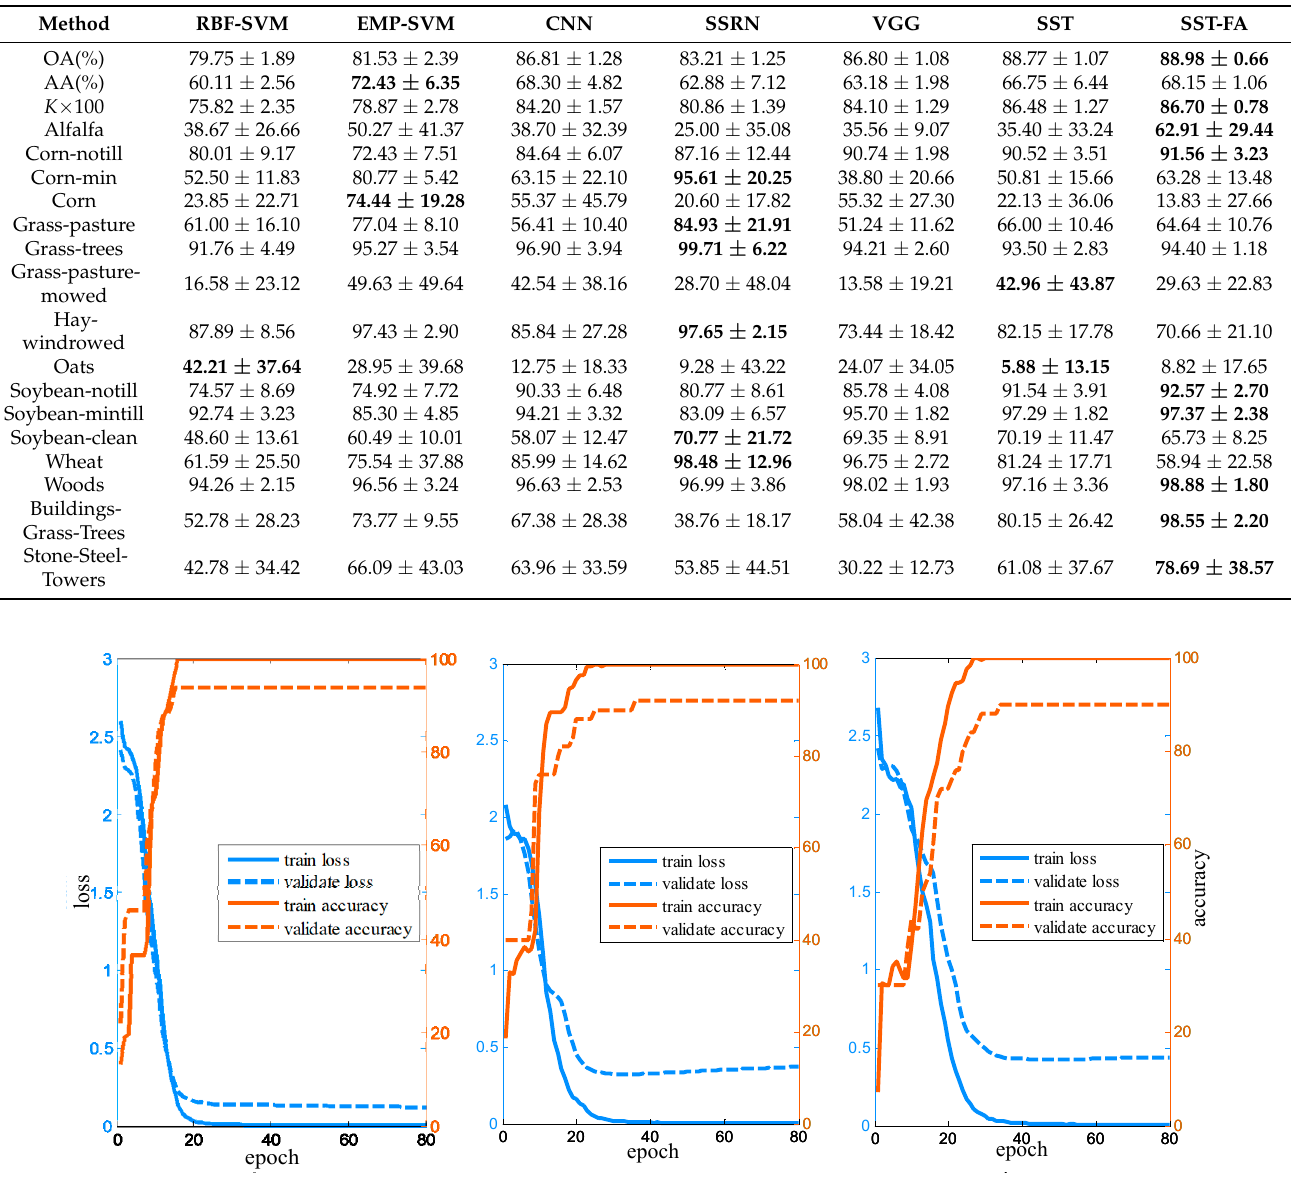
Table 4. Test accuracy with different preprocessing methods on the Indian Pines dataset.